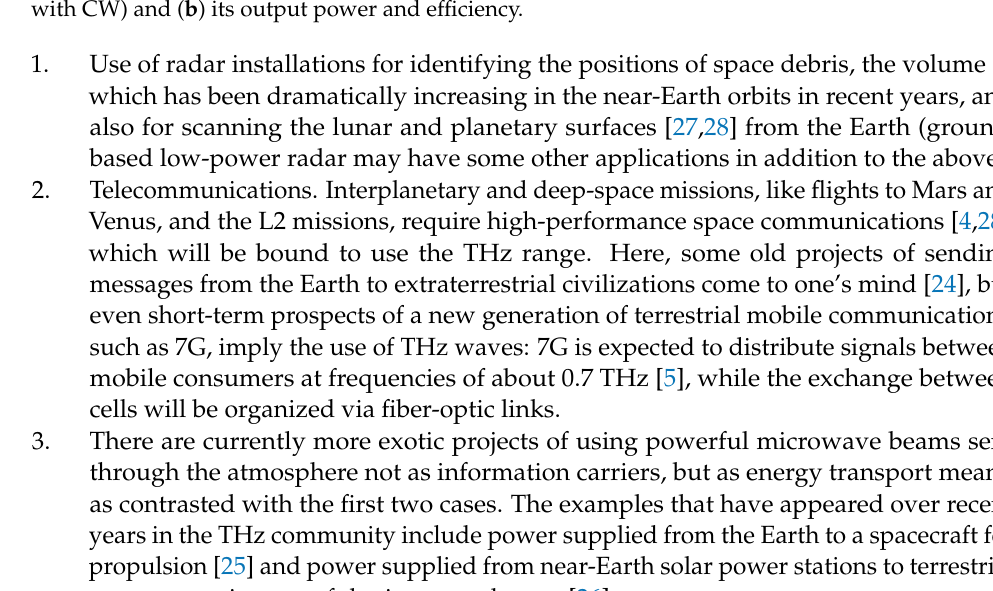
Figure 1. ( a ) Gyrotron for 250 GHz (330 kW with pulse duration about 100 microseconds, or 250 kW with CW) and ( b ) its output power and